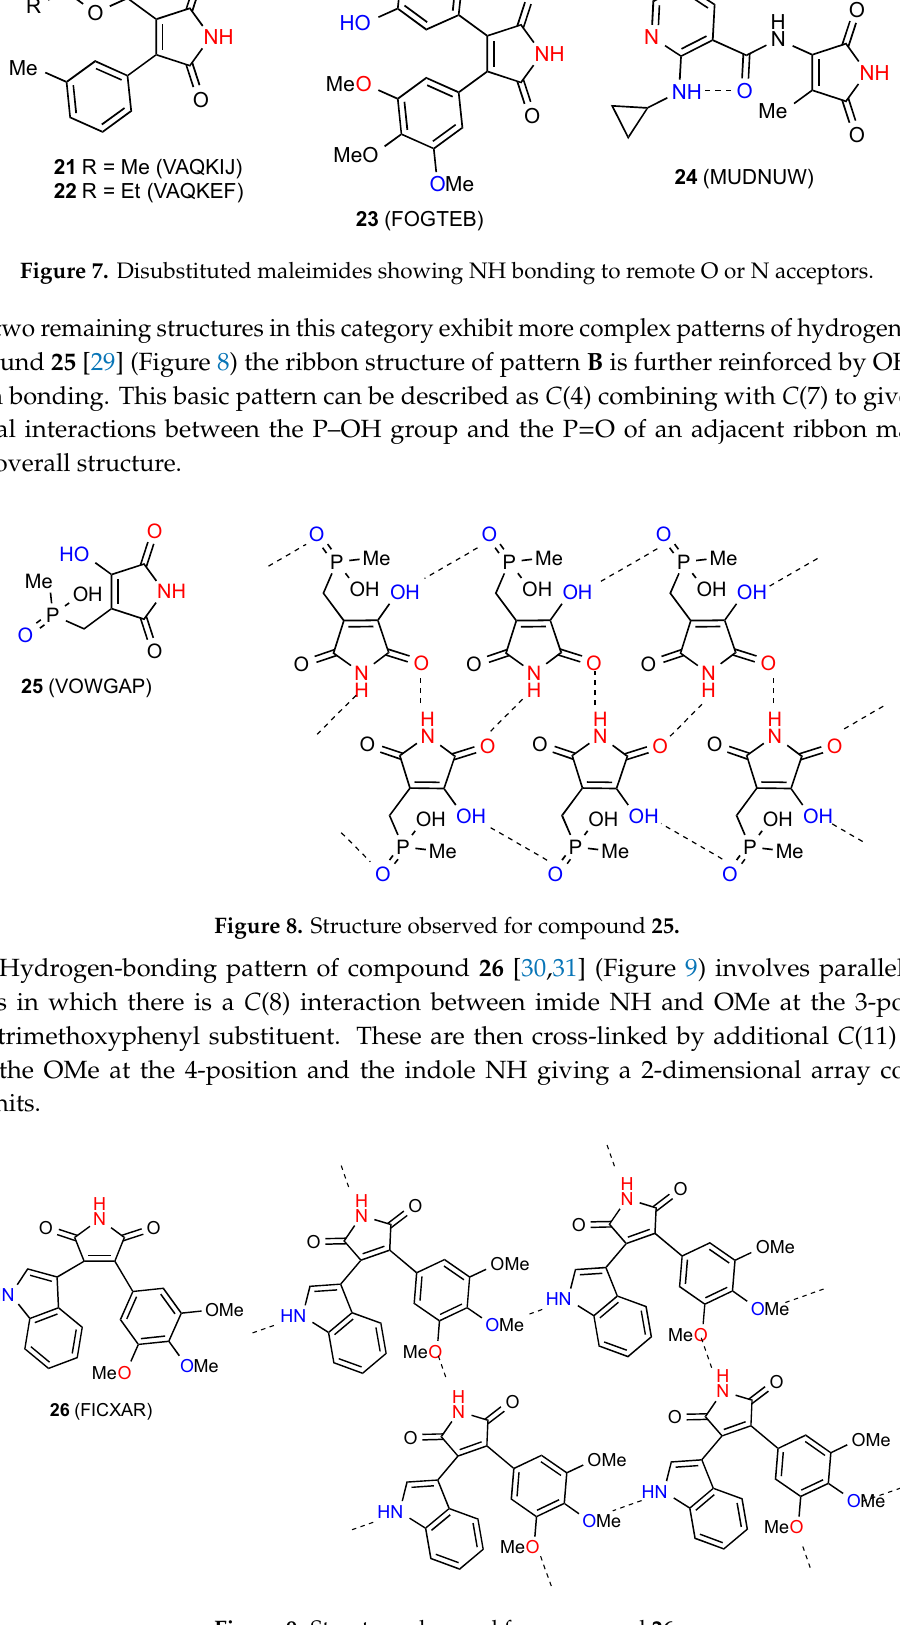
Figure 9. Structure observed for compound 26.